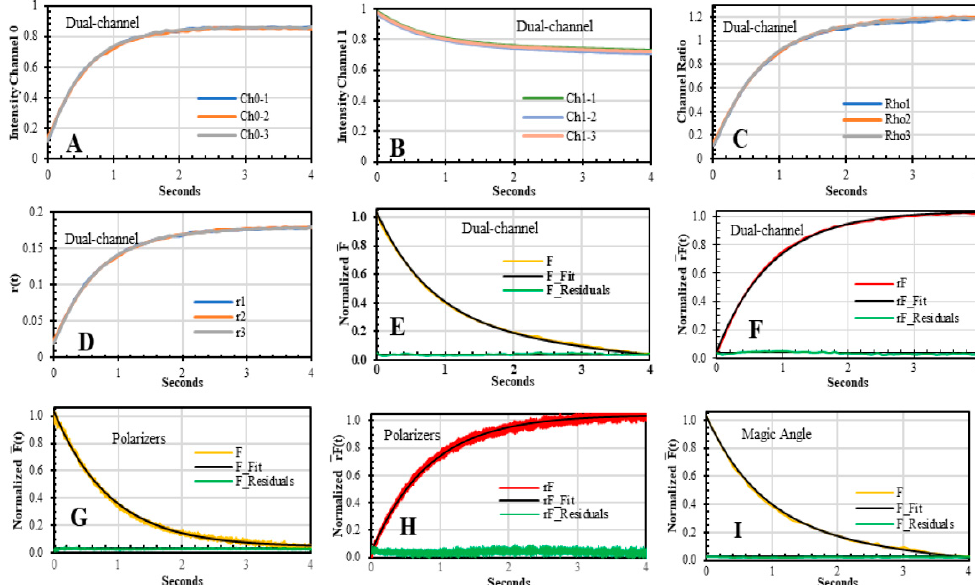
Figure 6. Stopped-flow kinetic traces acquired by dual-channel ( A – F ), polarizers ( G , H ), and magic-angle ( I ) methodologies for the binding association of BcO (20 nM) and AV (200 nM) at 20 ◦ C. The F(t) and rF(t) sensing modalities were employed to track the AV-BcO complex formation. For the former trace, the ∆ F decreased as the BcO fluorescence is quenched when the complex is formed and it is equivalent to ∆ QY (Table 2), and in the case of the rF(t) , the trace value increased as the probe binds to the protein decreasing its rotation. ( A , B ) The dual-channel V AC (t) and V DC (t) traces were collected in channels 0 and 1, respectively. ( C , D ) The endpoint ratio of channel 0 and channel 1, ρ ( ∞ ) = 1.2, and the r ss of the AV-BcO complex are used to solve for the r(t) traces according to Equation (7) (Table 2) to later obtain the F ( t ) (Equation (8)), and subsequently the rF ( t ) traces. ( E ) The F ( t ) traces were solved with Equation (8) and the respective fitted curves (black line, and residual in green) yielded two eigenvalues of λ 1 = 1.186 s − 1 ± 0.046 s − 1 and λ 2 = 0.02 ± 0.01 s − 1 (Table 3). The latter λ corresponds to photobleaching and is neglected from further analysis. ( F ) The ⎯ rF(t) fitting parameters yielded an λ = 1.183 s − 1 ± 0.023 s − 1 as the probe’s rotation decreases in the newly formed complex. ( G , H ) The 𝐹 (cid:3364) (𝑡) and 𝑟𝐹 (cid:3364)(cid:3364)(cid:3364) (𝑡) association traces acquired by polarizers yielded mono-exponential decays with λ 1 = 1.198